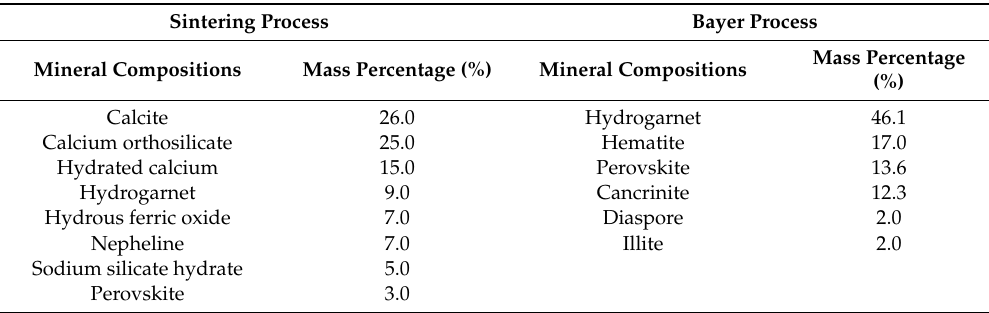
Table 2. The mineral compositions (or compounds) of typical red muds in